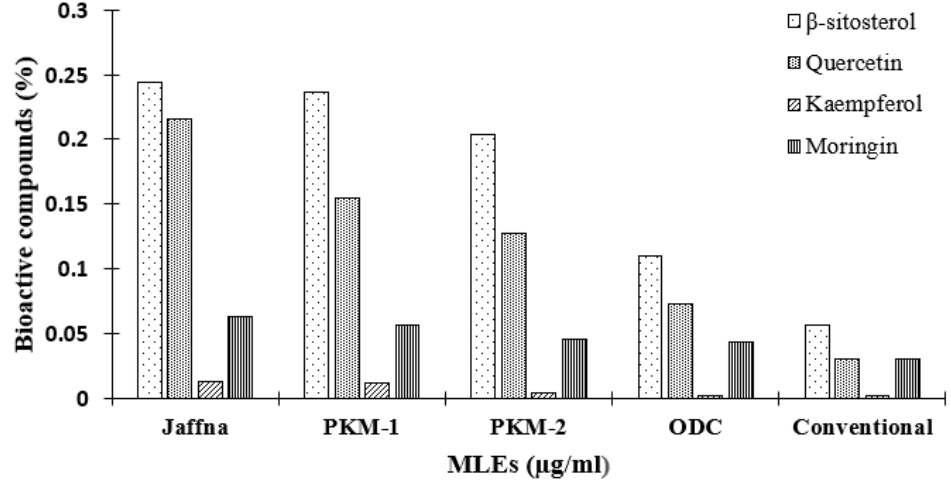
Figure 2. HPLC analysis of the selected anti-cancer compounds reported in MLEs.